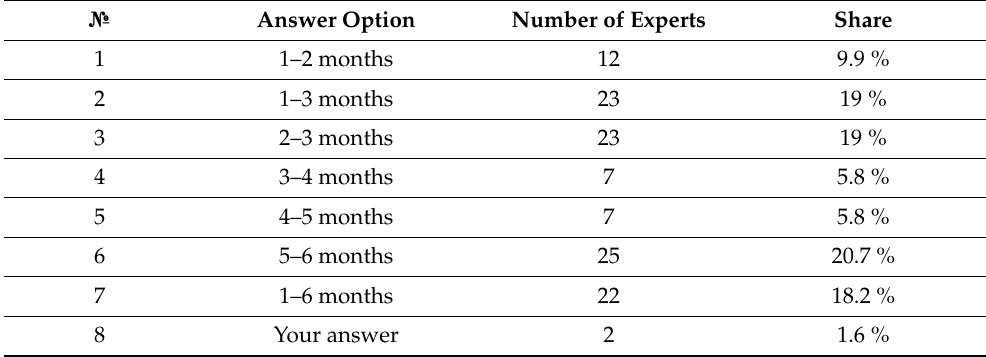
Table A1. Survey findings: identification of the interval for the duration of the procedure “Develop- ment of a construction project management plan together with the project owner”.